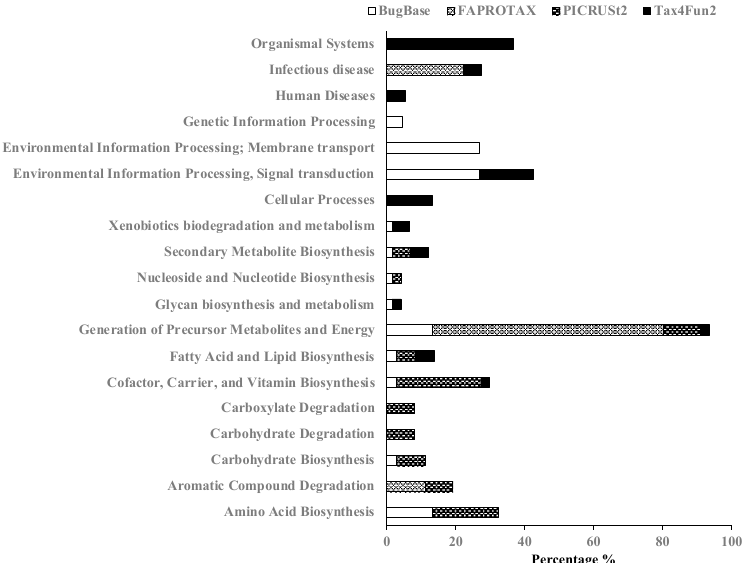
Figure 1. The relative abundance of the pathway categories on the anode-associated soils by the BugBase, FAPTROTAX, PICRUST2, and Tax4Fun2 tools.